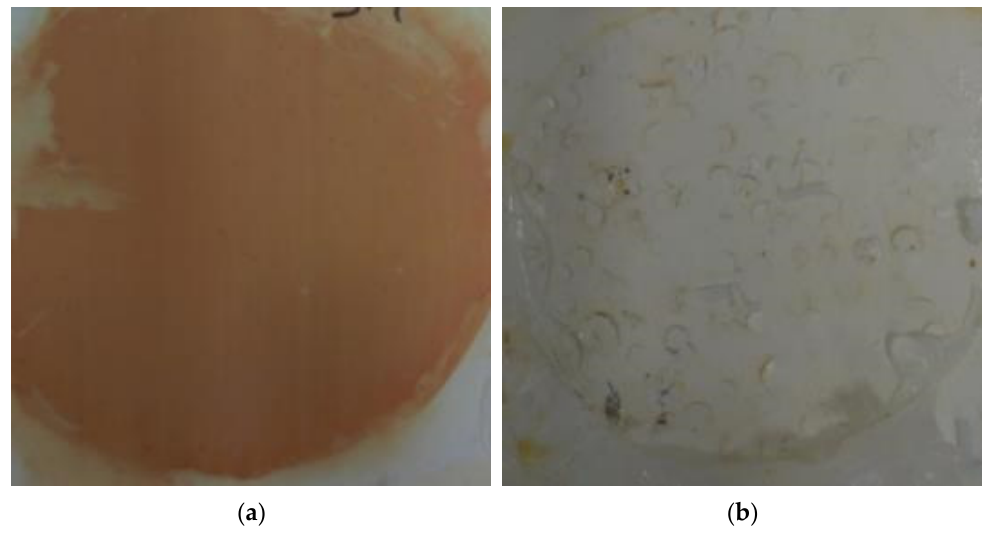
Figure 6. NBR-REF coating containing rounded silica particles after chemical loading: ( a ) colour change of the coating exposed to 30% HCl for 90 days; ( b ) cracking of the coating exposed to 30% CH 2 O 2 for 60 days.